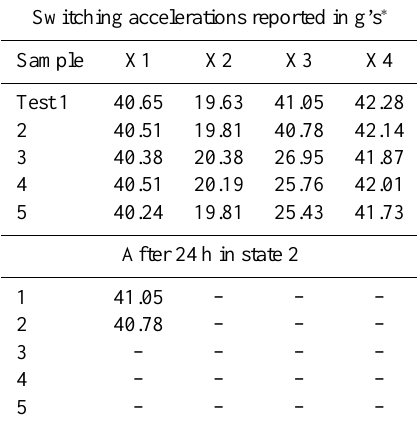
Table A1. Accelerometers that broke during handling /